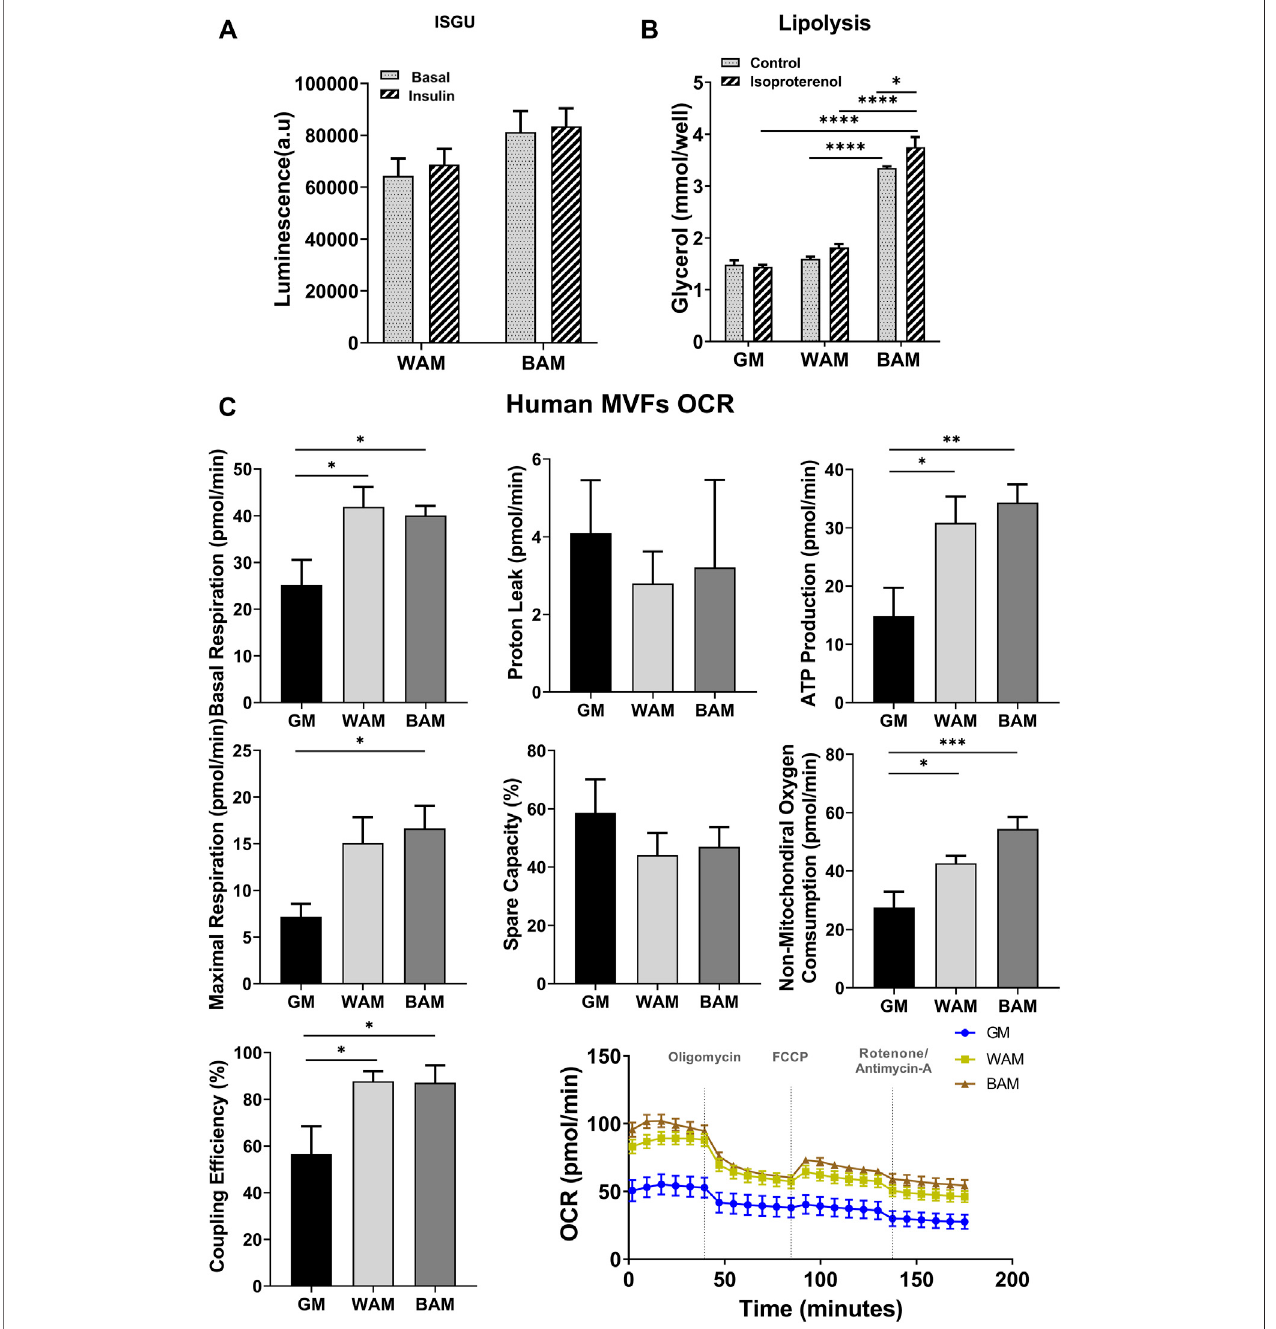
FIGURE 3 | Functional analysis of beige adipose tissue formation in direct adipogenic culture of human microvascular fragments (hMVFs). hMVFs were directly exposed to white (WAM) or beige (BAM) adipogenic media for 14 days. At the end of the 14 days, (A) insulin-stimulated glucose uptake (ISGU) ± insulin, to stimulate glucose uptake, and (B) lipolysis ± isoproterenol, to stimulate lipolysis were measured. (C) Oxygen consumption rate (OCR) trace was determined using a Seahorse XF96 Analyzer among the different groups. Basal respiration, proton leak, maximal respiration, ATP production, non-mitochondrial oxygen consumption, coupling ef fi ciency, and spare capacity were calculated. Results are reported as mean ± standard error of two experimental replicates ( n = 4). * = p < 0.05, ** = p < 0.01, *** = p < 0.001, and **** = p < 0.0001.